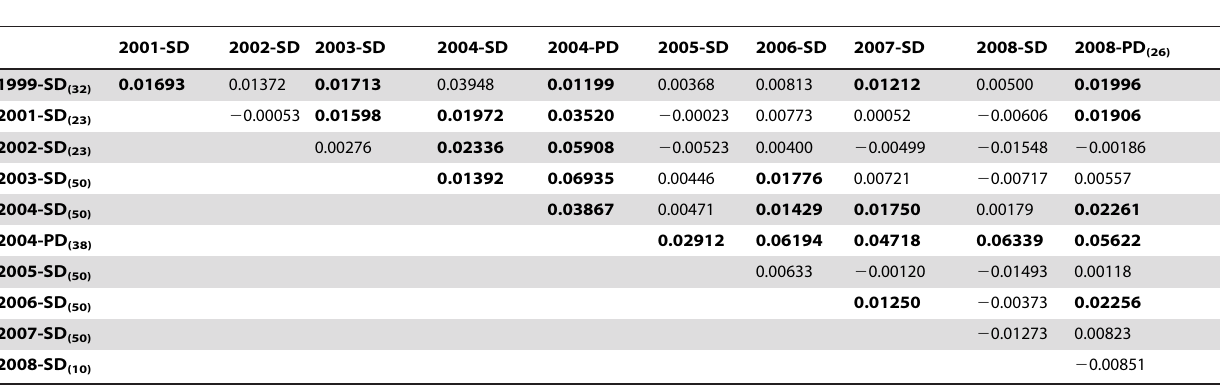
Table 4. Pairwise Fst divergence between 12 groups of M. schimitscheki produced between 1999 and 2008, expressing either